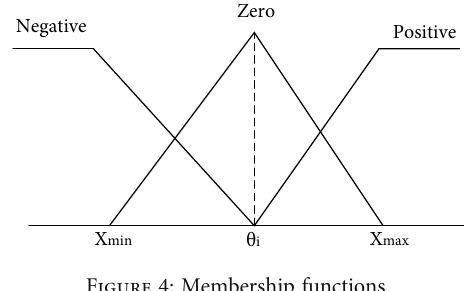
Figure 4: Membership functions. Table 1: Two-stage scheme of fuzzy rules.